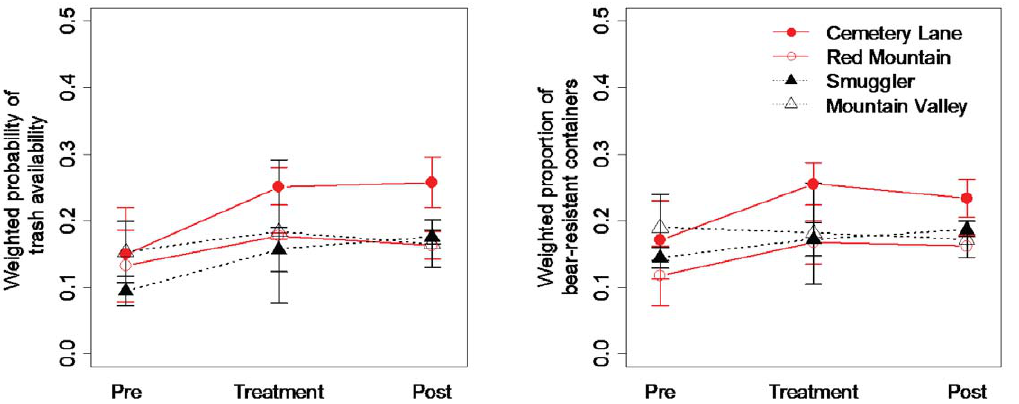
Figure 4. Results of Bear Aware education experiment. Differences in mean ( 6 1 SE) weighted probability of availability of trash to bears and mean weighted proportion of bear resistant containers in treatment (red) and control (black) neighborhoods for a 2008 experiment testing the efficacy of a Bear Aware education campaign as a management tool in reducing availability of garbage to bears in four residential neighborhoods in Aspen, Colorado, USA. Responses are weighted by the proportion of containers detected in each sampling occasion. Sampling periods are pre- treatment (Pre), treatment-application (Treatment), and post-treatment (Post). Neighborhoods are Cemetery Lane (BA1), Red Mountain (BA2), Lower Smuggler (BA3), and Mountain Valley (BA4).